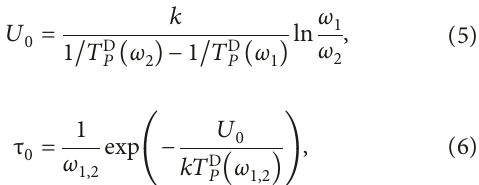
2 μ m; 4-Zr-0, (cid:29) 113nm; 7-Zr-02CE, (cid:29)